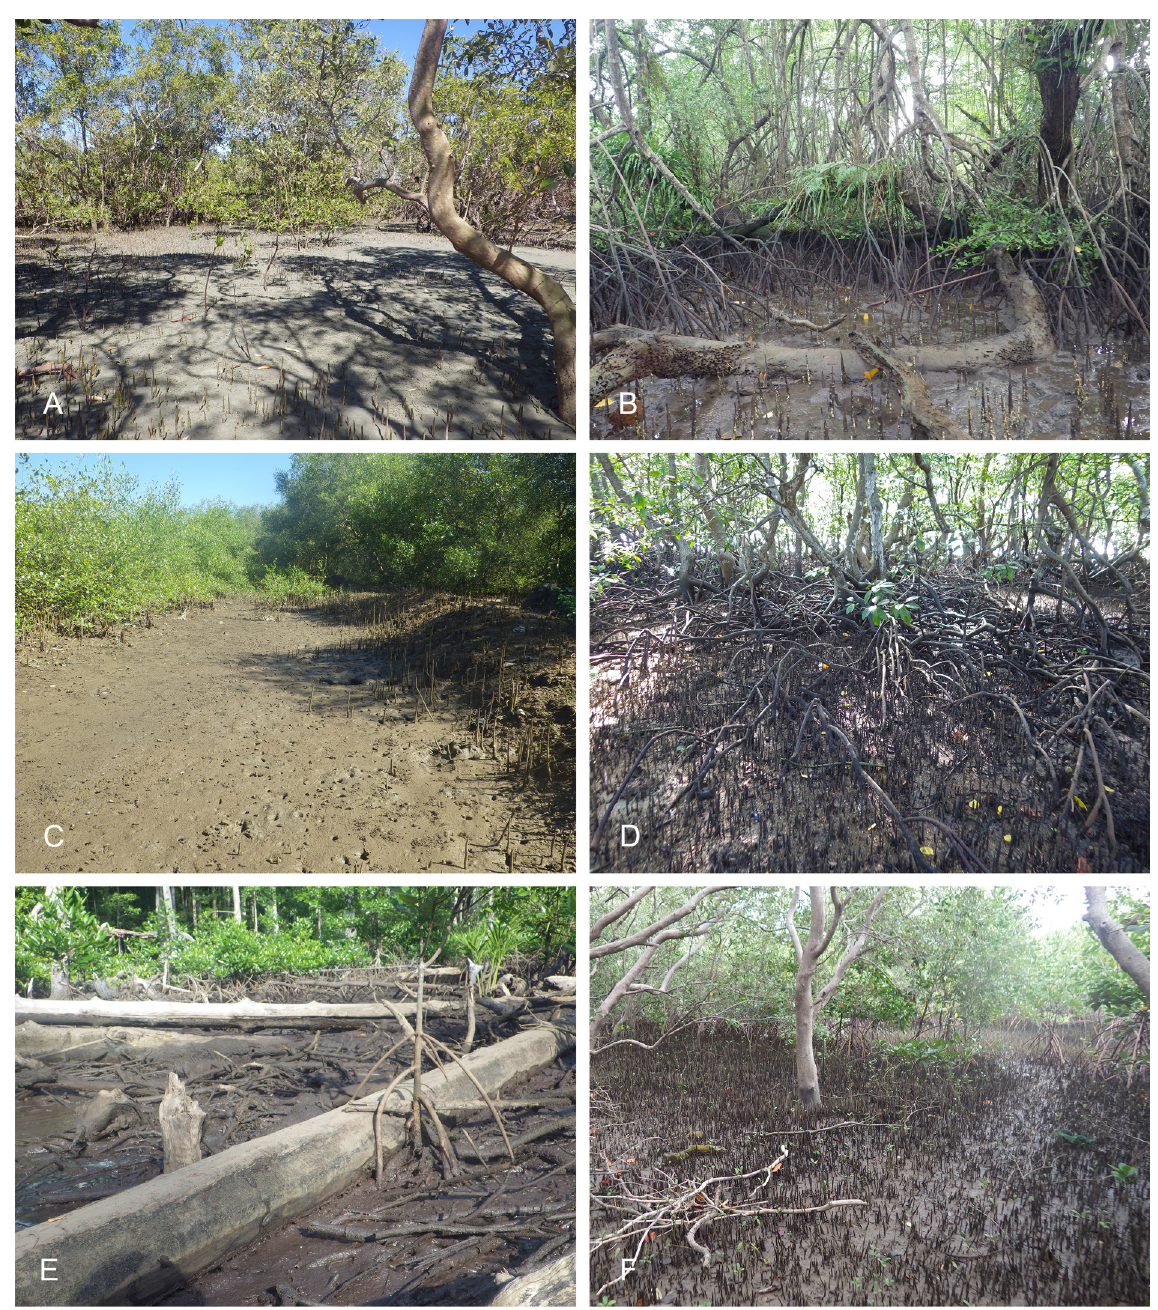
Fig. 24. Paromoionchis tumidus (Semper, 1880) comb. nov. unit #1, habitats. A . Australia, Queensland, mangrove by creek with Rhizophora and Avicennia (station 119). B . Indonesia, Ambon, mangrove with large Rhizophora and some open spaces between trees (station 131). C . Indonesia, Lombok, mudflat at the margin of mangrove (station 145). D . Philippines, Bohol, narrow forest on the edge of fish ponds, with tall Rhizophora and Avicennia trees, and different types of mud (station 194). E . Indonesia, Halmahera, logged area by an old Rhizophora forest (station 212). F . Vietnam, Nha Trang, mostly Avicennia trees, mud not deep (station